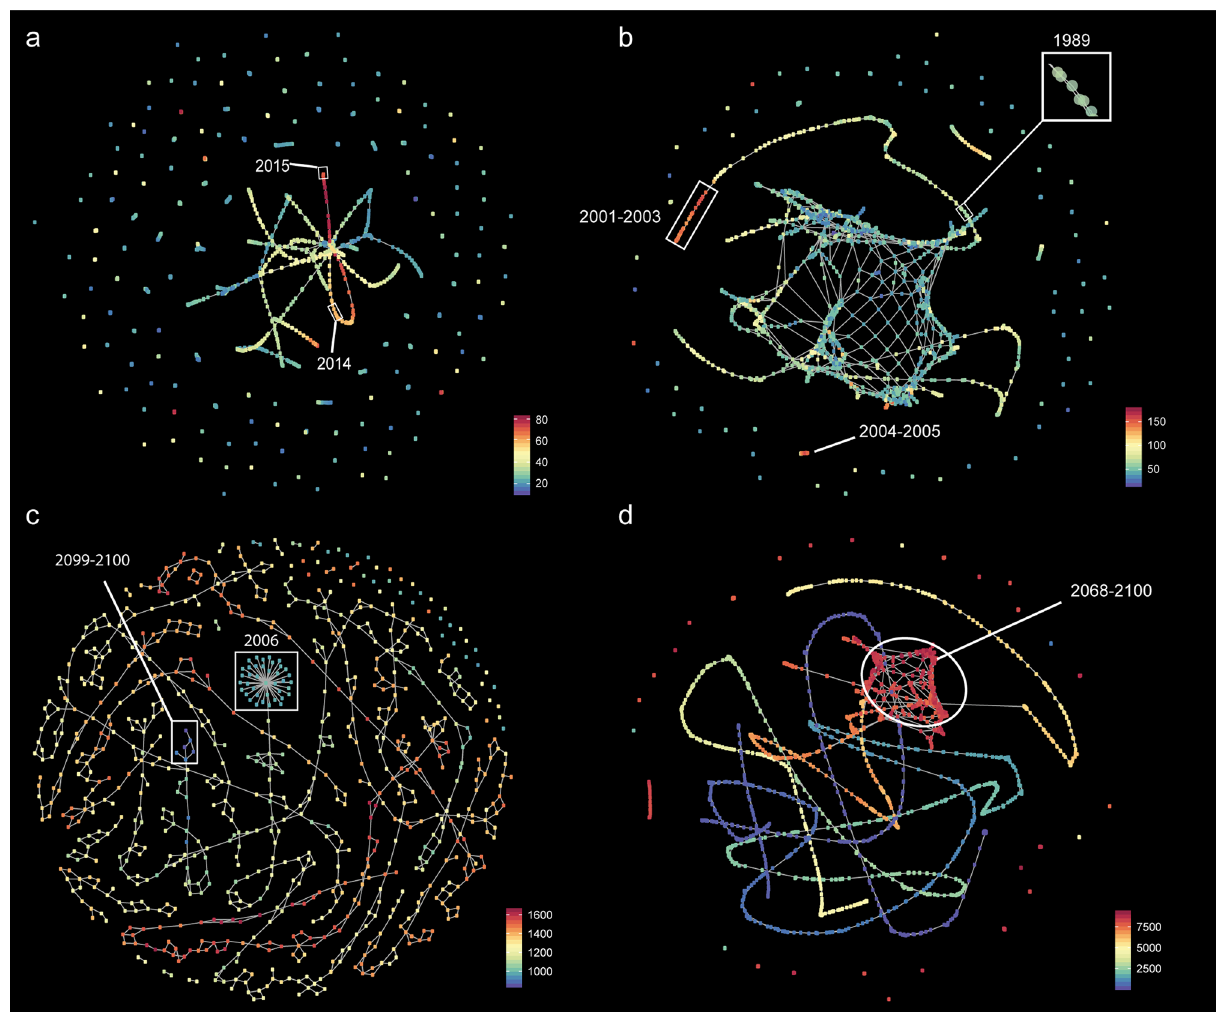
Figure 2. A network representation of globally distributed MHWs. Networks generated by the TDA-based Mapper algorithm are annotated by the duration of MHWs averaged across timeframes in each node. ( a ) Network of observed SSTs (1981–2018) showing the prevalence of isolated events. The white frames highlight subsets of nodes encoding part of the long-lasting northeastern Pacific MHW known as ‘the blob’ (see also Supplementary Fig. 1a); ( b ) Network of simulated SSTs from the Historical CO 2 emission scenario (1861– 2005). The inset shows the ramification of loosely connected nodes starting in 1989 and initiating a pathway of increasing MHW duration toward the end of the historical period (white frame and isolated 2004–2005 nodes); ( c ) Network of simulated SSTs from the RCP 2.6 CO 2 emission scenario (2006–2100). There is no evidence of increasing duration of MHWs from the beginning to the end of the simulation period (white frames); ( d ) Network of simulated SSTs from the RCP 8.5 CO 2 emission scenario (2006–2100). A region of densely connected nodes emerges in the second half of the simulation period (red nodes in the white circle), corresponding to persistent MHWs covering vast areas of the global ocean (Supplementary Fig. node degree compared to null models (Fig. 3). The network shows longer and more intense MHWs towards the end of the simulation period (Fig. 2b, Supplementary Figs. 1, 2). The network originating from the RCP 2.6 sce- nario (2006–2100) has loosely connected nodes (Fig. 2c) with significantly larger modularity and significantly lower node degree compared to null models, a pattern similar to that identified in the network of observed MHWs (Fig. 3). Ground-breaking events are distributed across the network with no evidence of worsening conditions towards the end of the century (Fig. 2c, Supplementary Figs. 1, 2). The network originating from the RCP 8.5 scenario (2006–2100) shows ramifications of loosely connected nodes and a region of densely con- nected nodes that reflects record-breaking MHWs for duration and intensity that emerge in the second half of the twenty-first century (Fig. 2d, Supplementary Figs. 1, 2). Network modularity is significantly lower and node degree significantly larger than in null models (Fig. 3). Transitions between dynamical regimes. The co-occurrence of regions with high and low node degree within the historical and RCP 8.5 networks suggests transitions between distinct dynamical regimes in the evo-